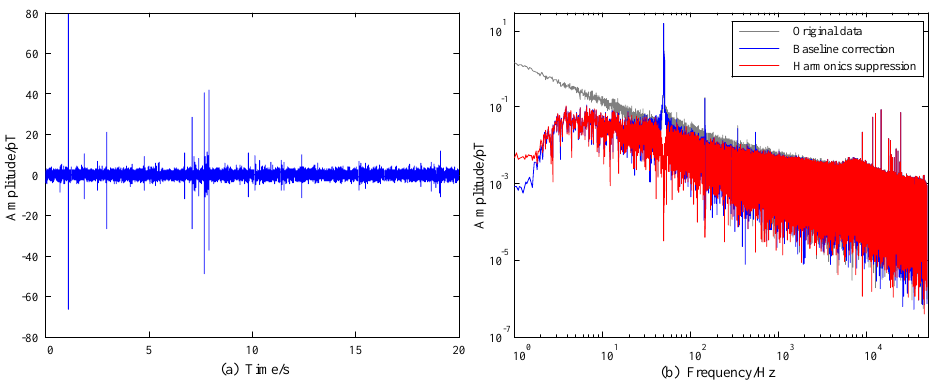
Figure 5. Processed data by the proposed method: ( a ) waveform after processing, and ( b ) comparison of Spectra.